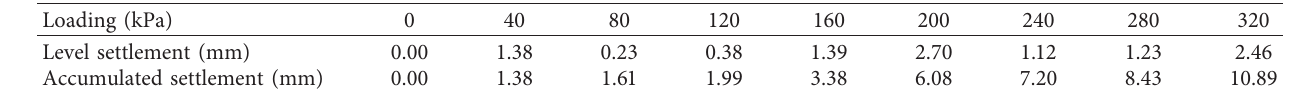
Figure 4: Pictures of test loading process. Table 2: Load settlement data curve.